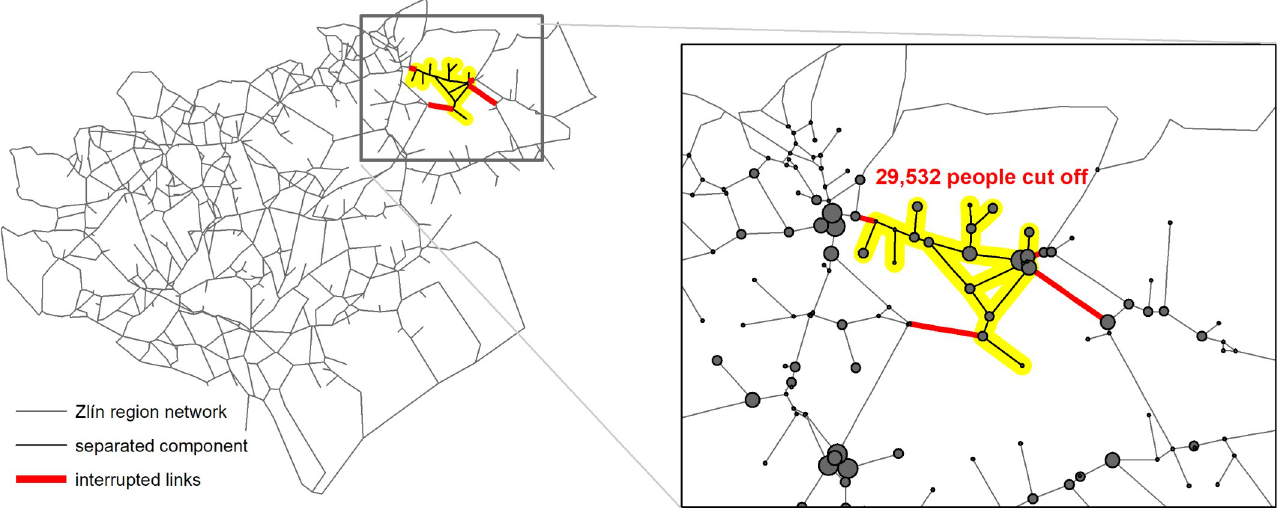
Fig 4. The second-worst-case scenario for the Zlı´n region. A node diameter represents proportionally the number of inhabitants. The worst scenario is not shown here because it is represented by only one cut-off node, the center of the city of Zlı´n. This case is more illustrative.